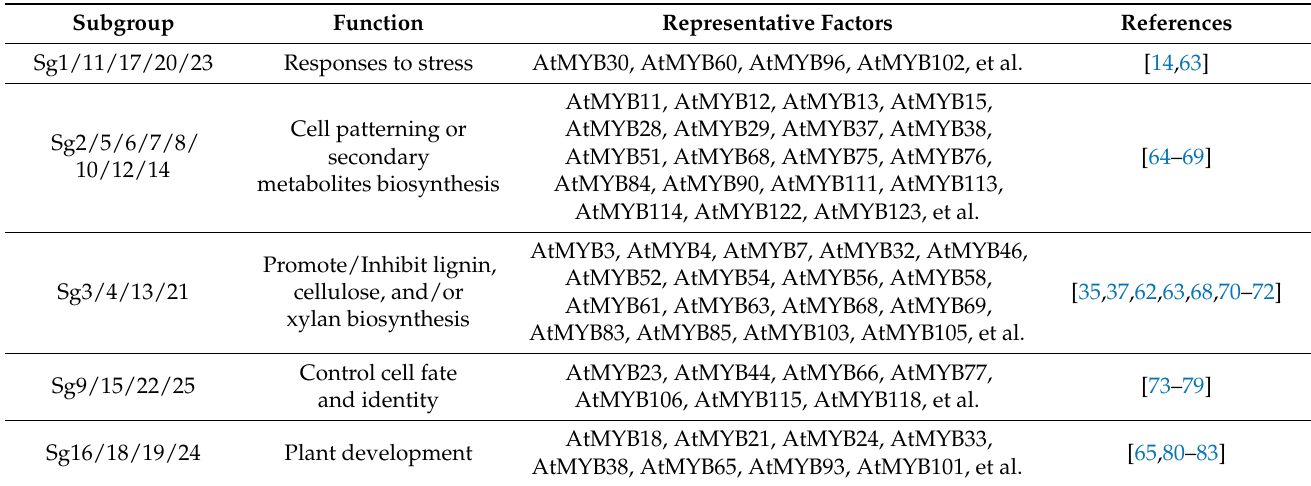
Table 1. Major R2R3-MYB subgroups in Arabidopsis and their functions. Function Representative